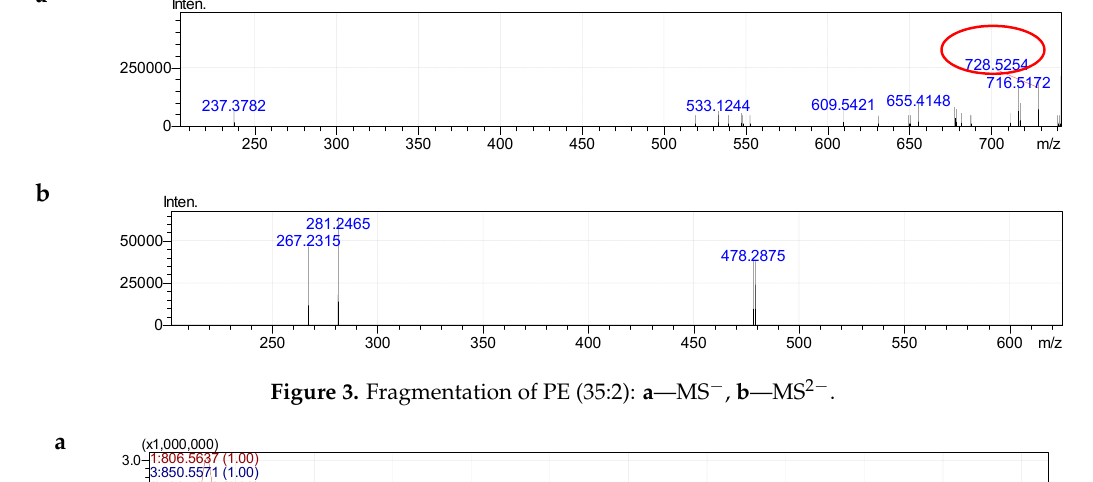
Molecules 2019 , 24 , x FOR PEER REVIEW Figure 3. Fragmentation of PE (35:2): a —MS − , b —MS 2 − . Figure 3. Fragmentation of PE (35:2): a —MS − , b —MS 2 − .